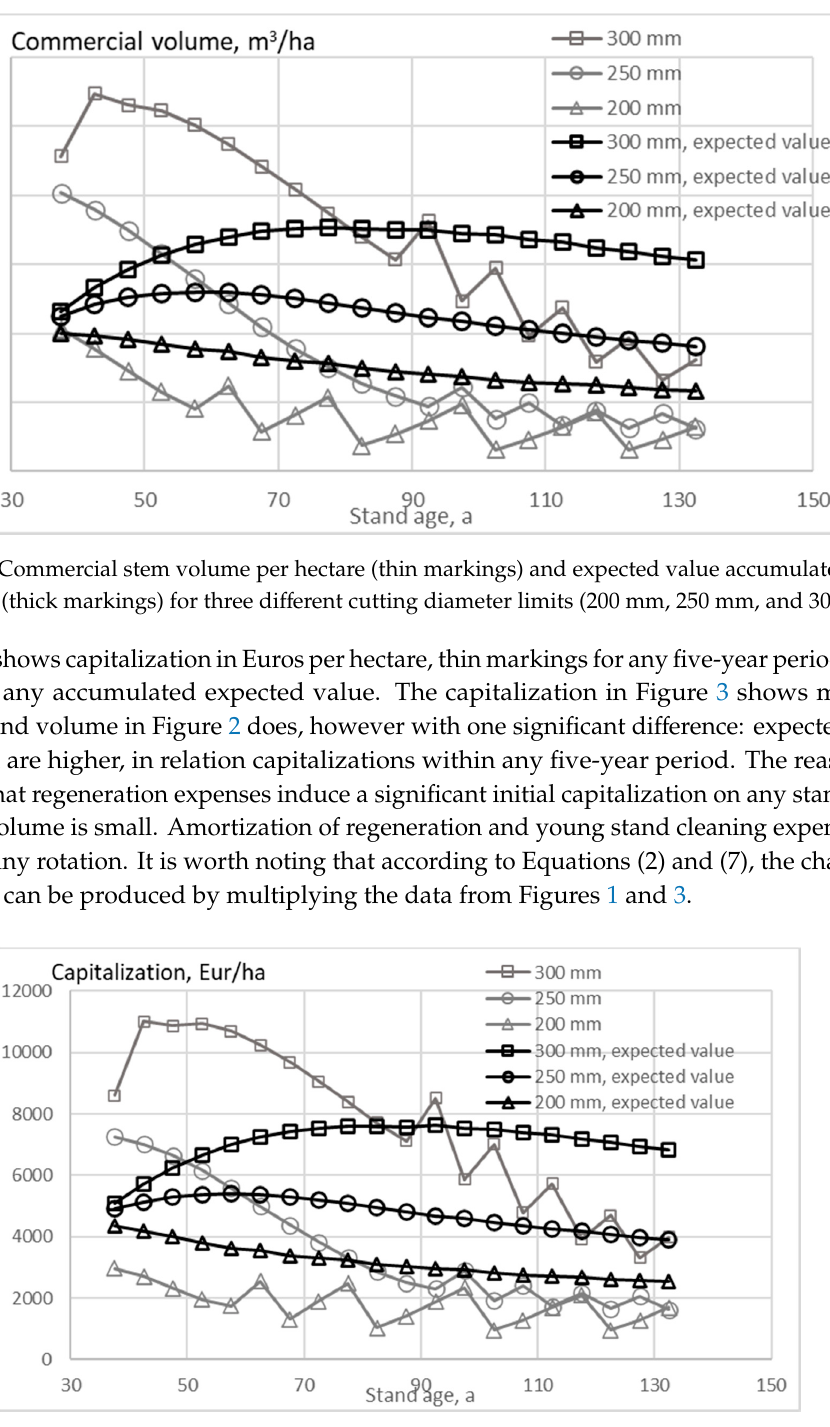
Figure 3. Capitalization per hectare (thin markings) and expected values accumulated over stand age (thick markings) for three different cutting diameter limits (200 mm, 250 mm, and 300 mm).